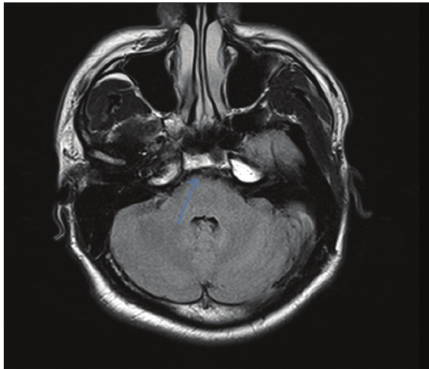
Figure 5: MRI of brain T1 axial + gadolinium with resolution of previously visualized enhancing lesion, after anti-TB